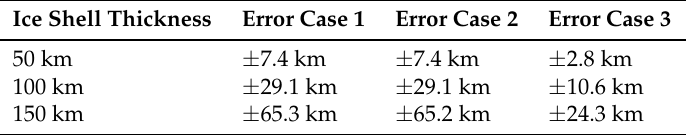
Table 3. Constraint on the ice shell thickness from the 7.16-day libration period. Results are presented for the three different error cases as a function of the true ice shell